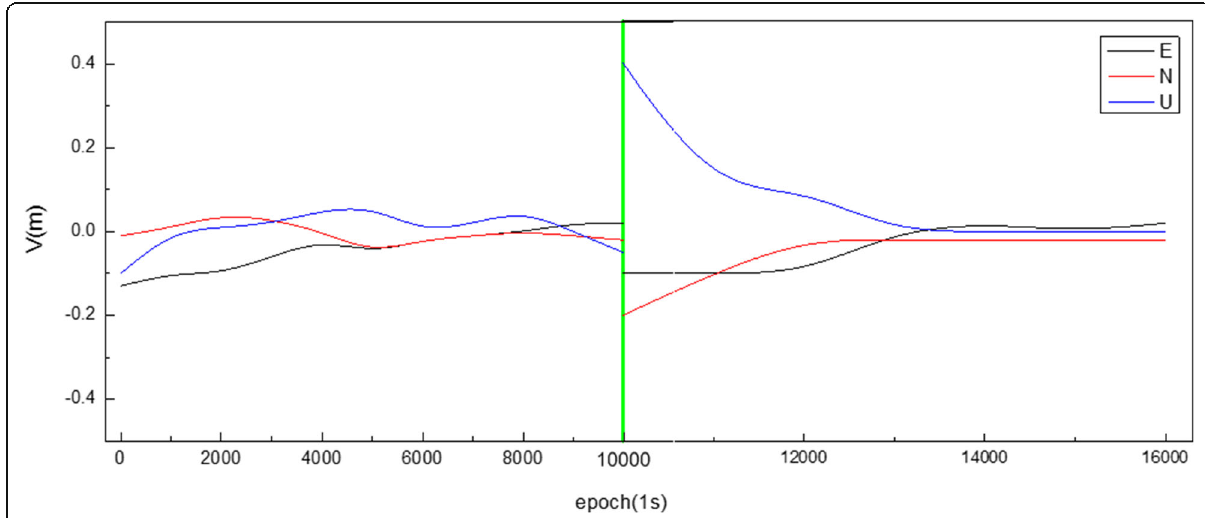
Fig. 8 Dynamic positioning deviation and RMS value of case 2 (with gross